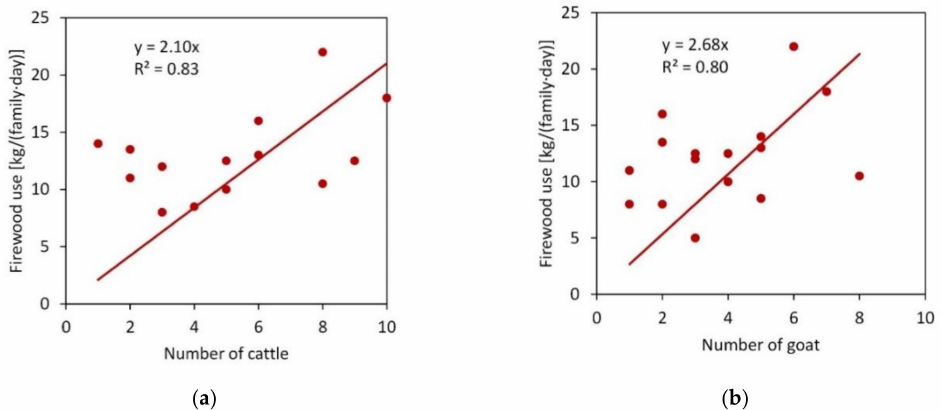
Figure 6. Relationship between firewood consumption and livestock rearing: ( a ) Cattle rearing and ( b ) Goat